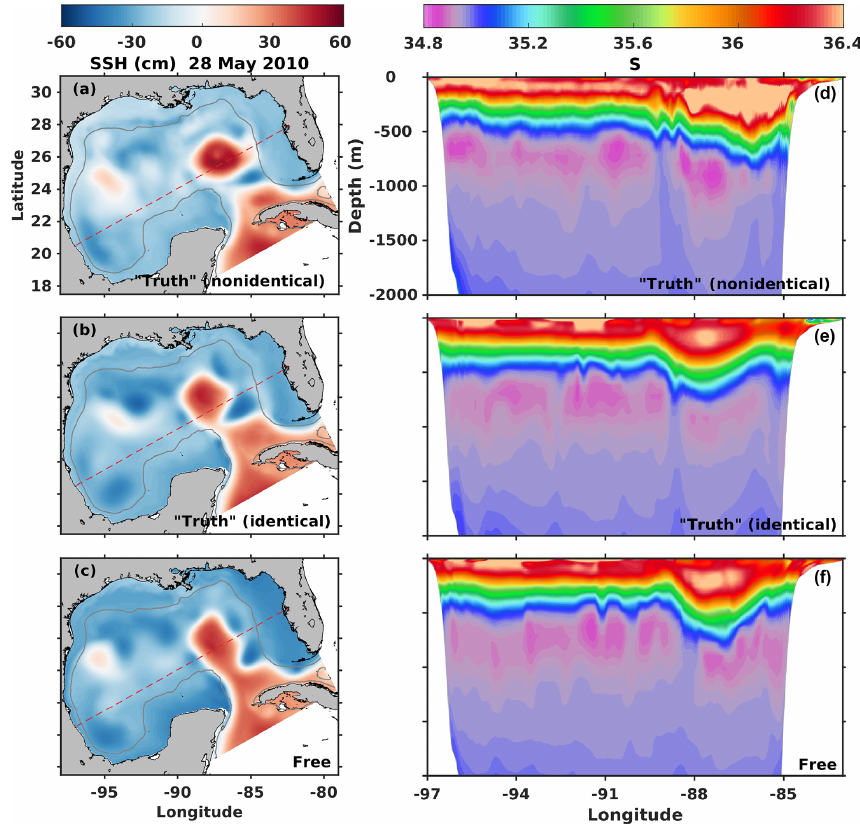
Figure 3. Sea surface height (SSH, cm) and transect of salinity ( S ) on 28 May 2010. Panels (a) and (d) are from HYCOM and used as the “truth” in the nonidentical twin experiments. Panels (b) and (e) are from ROMS and used as the truth in identical twin experiments. Panels (c) and (f) are from the free ROMS run. The gray contour in the SSH maps marks the bathymetric depth of 300m, and the red dashed line shows the position of the transect in panels (d) – (f)